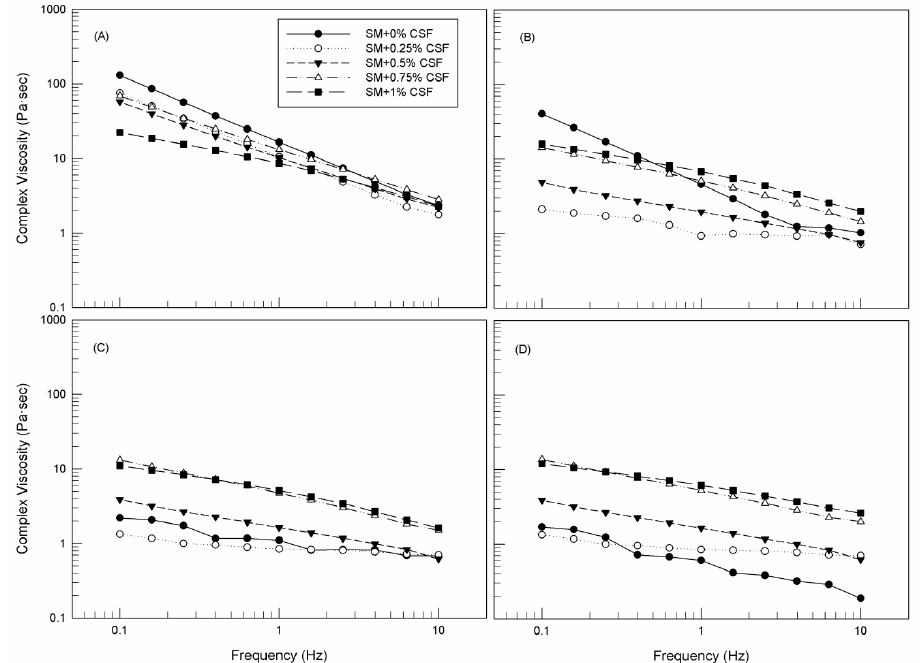
Figure 2. Complex viscosity (Pa·sec) versus frequency (Hz) for yogurt-like structures made of soy milk and increasing concentration of carob seed flour. The samples were analyzed at time 0 ( A ), 24 h ( B ), 48 h ( C ) and 5 ( D ) days of storage. The illustrated results were representative of three independent experiments.